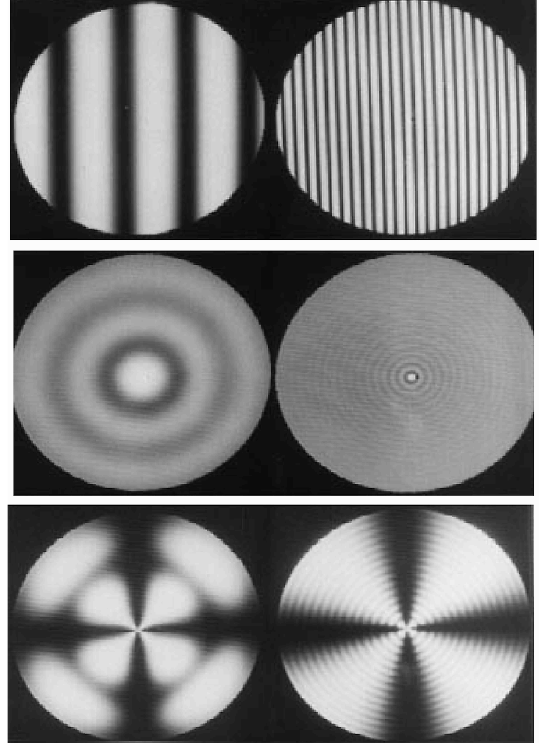
Figura 1. Exemplos de est(cid:237)mulos elementares de 0,5 e